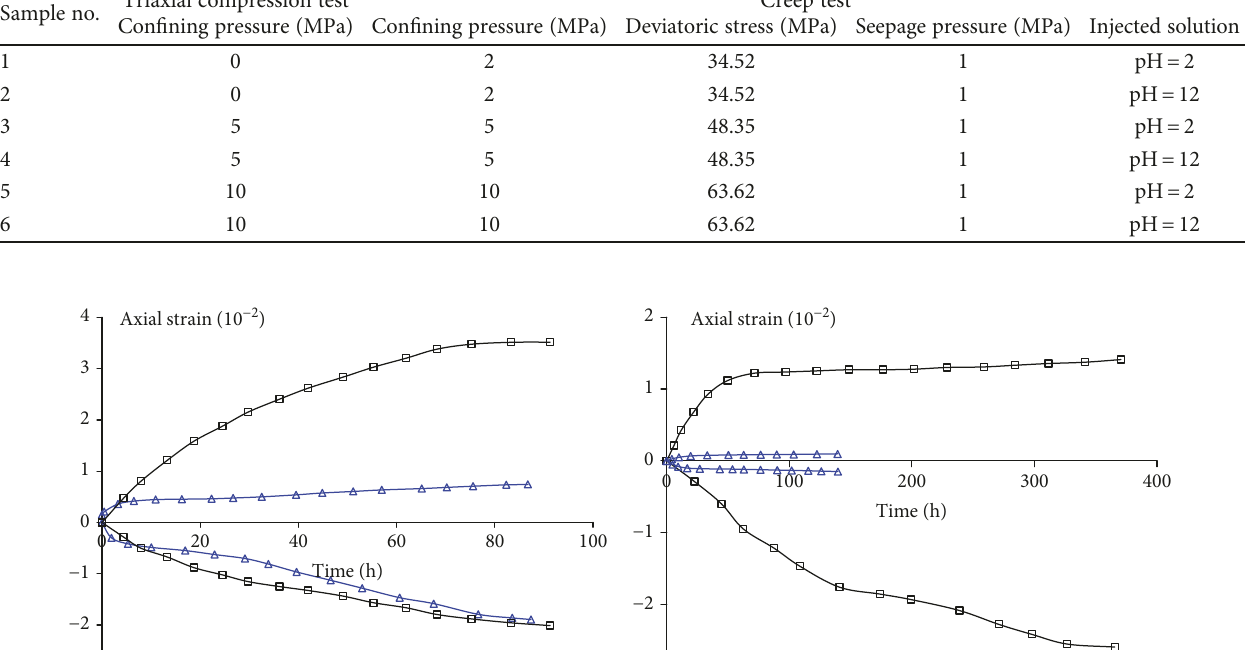
Table 1: Detailed information of the samples used in the triaxial compression tests and creep tests. Triaxial compression test Sample no.